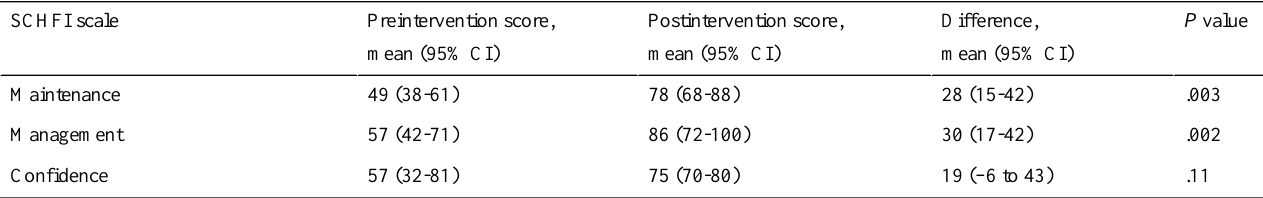
Table 4. Self-Care of Heart Failure Index (SCHFI) scales preintervention and postintervention (n=6).